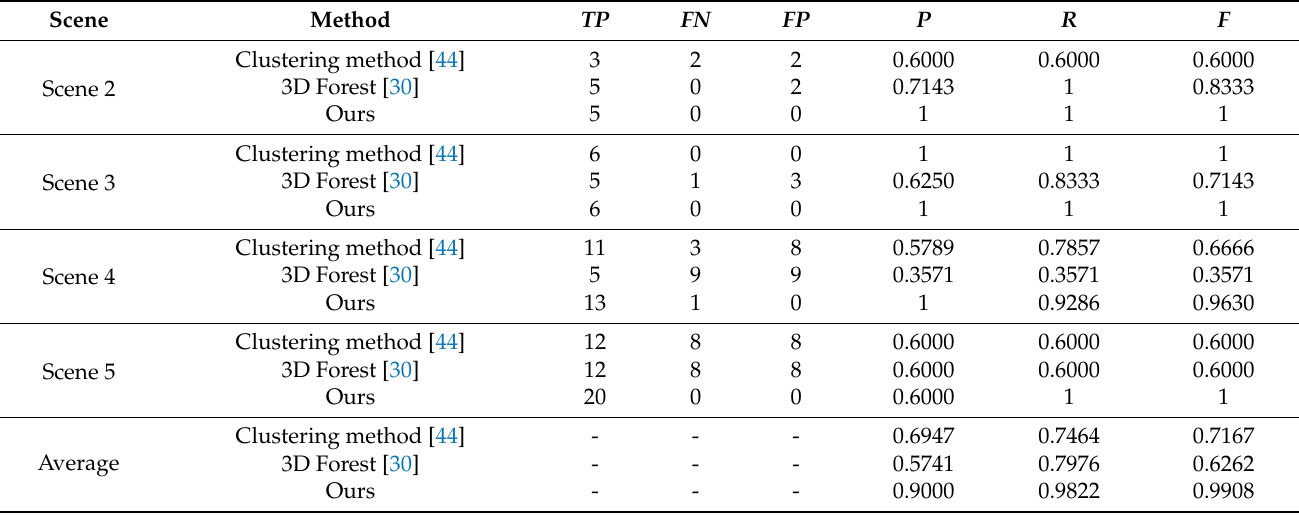
Table 2. Quantitative comparison results on four scenes.